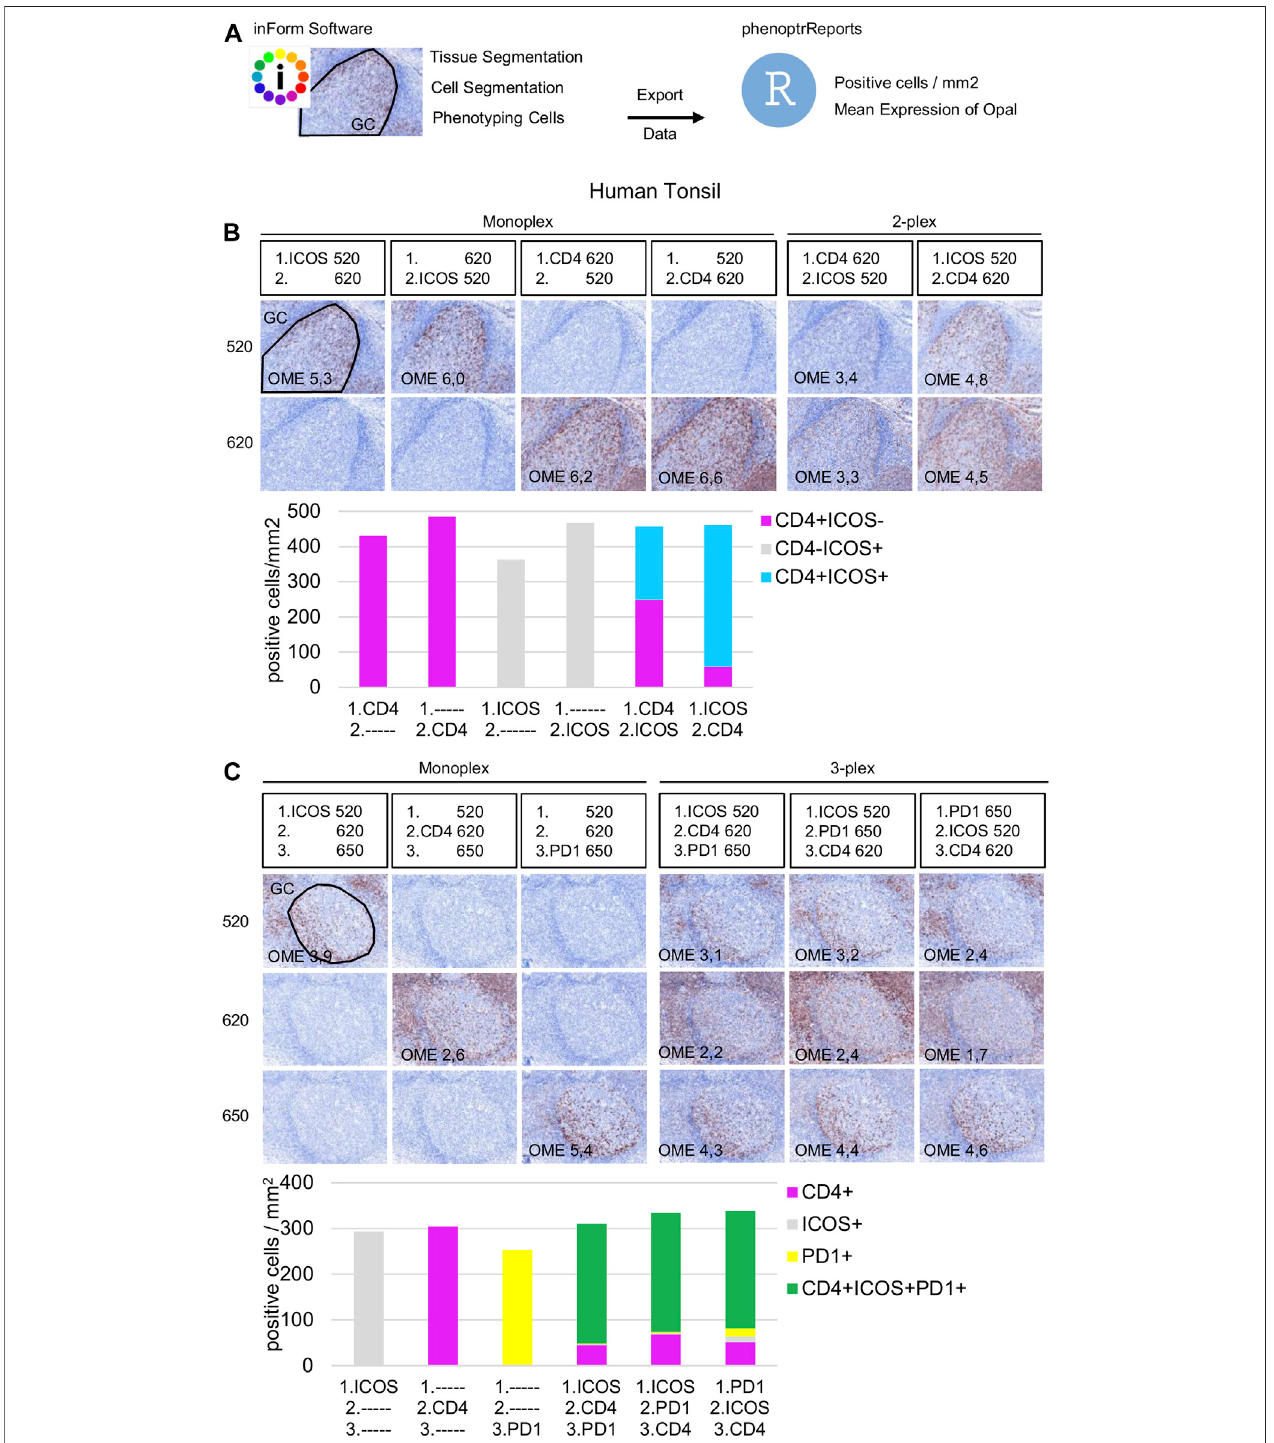
FIGURE 4 | Staining order optimization of three markers co-localized on the cell surface. (A) Work fl ow used to segment tissue regions, segment cells, and phenotype cells with the InForm software before quantifying cell density (positive cells/mm2) and Opal mean expression (OME) using PhenoptrReports on a germinal center (black line). (B) Simulated DAB IHC images of monoplex and 2-plex slides staining of consecutive FFPE tonsil sections alternating the position of CD4 and ICOS. The cell densities of CD4 + ICOS − (magenta), CD4 − ICOS + (grey), and CD4 + ICOS + (cyan) were quanti fi ed in the monoplex and 2-plex slides. (C) Simulated DAB IHC imagesofmonoplexand3-plexslidesstainedonconsecutiveFFPEtonsilsections,includingPD-1in fi rst,second,orthirdpositionintheICOS > CD4stainingorder.The celldensitiesoftotalCD4 + (magenta),totalICOS + (grey),totalPD1 + (yellow),andCD4 + ICOS + PD-1 + (green)werequanti fi edinthemonoplexand3-plexslides.Theslides were scanned at × 20 magni fi cation with the Vectra Polaris and the composite images were analyzed with InForm software (v.2.4.8) and PhenoptrReports (Kent S Johnson (2020). phenoptr: inForm Helper Functions. R package v.0.2.6. https://akoyabio.github.io/phenoptr/).